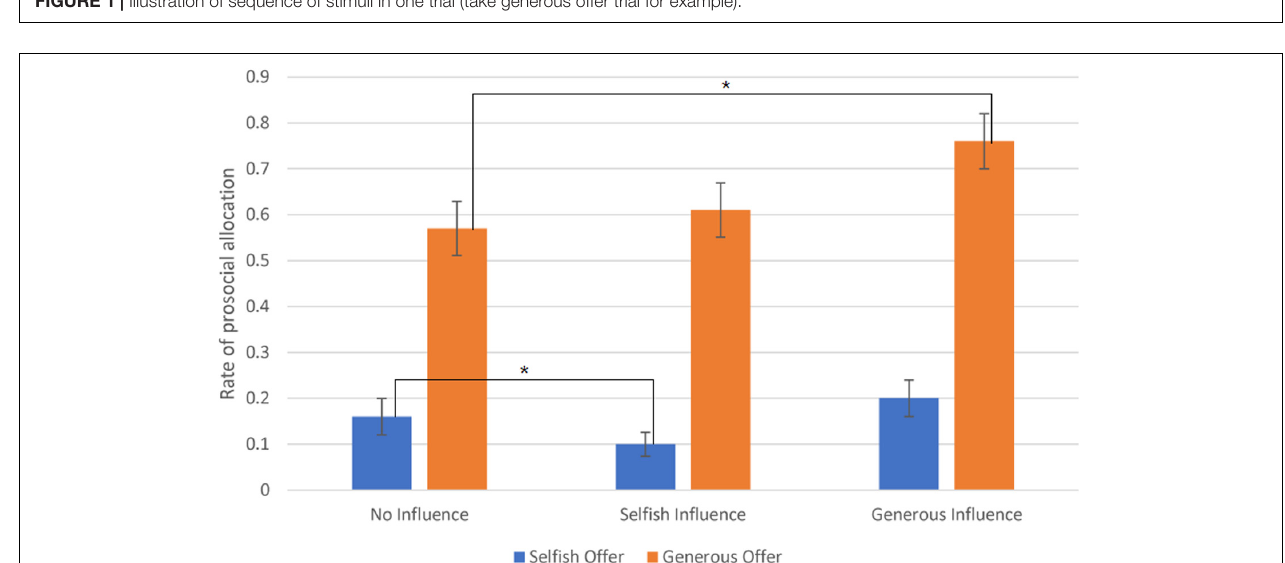
FIGURE 2 | The rate of allocate money to partner (Error bars indicate standard errors of the mean). ∗ p < 0.05.